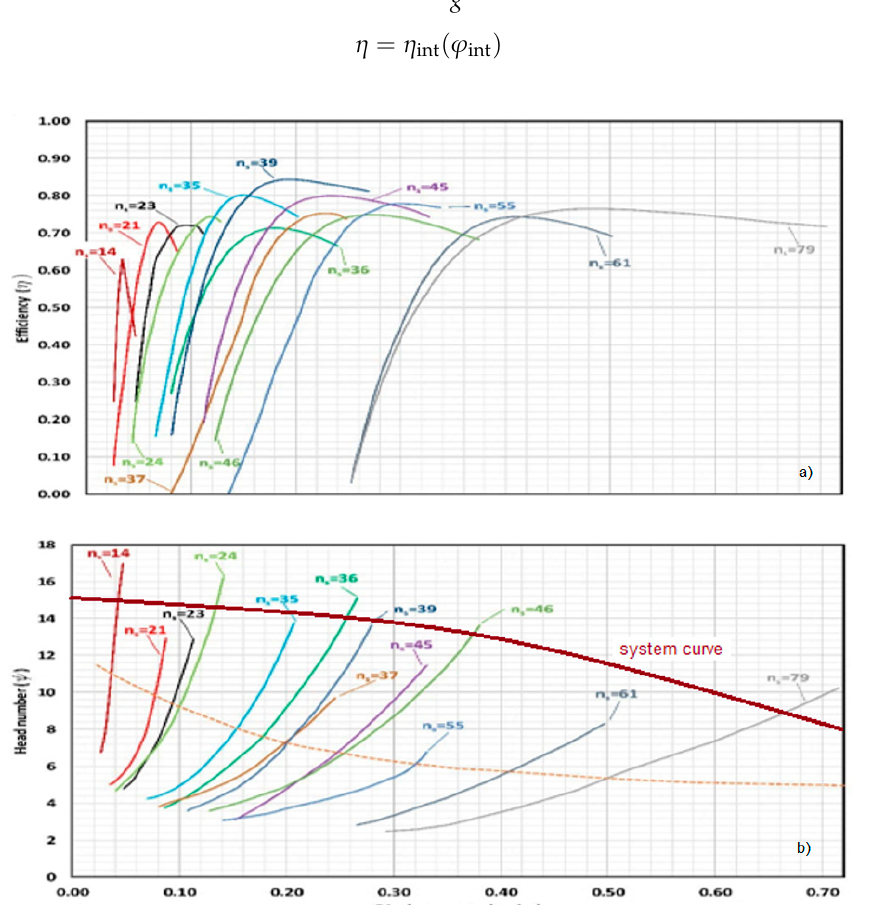
Figure 5. Pump as turbine (PAT) characteristic curves for di ff erent specific speed values, based on Figure 5. P ump as turbine (PAT) characteristic curves for different specific speed values, based on experimental tests and a ffi nity laws (adapted from [25]): ( a ) e ffi ciency curves; ( b ) head experimental tests and affinity laws (adapted from [25]): ( a ) efficiency curves; ( b ) head curves.